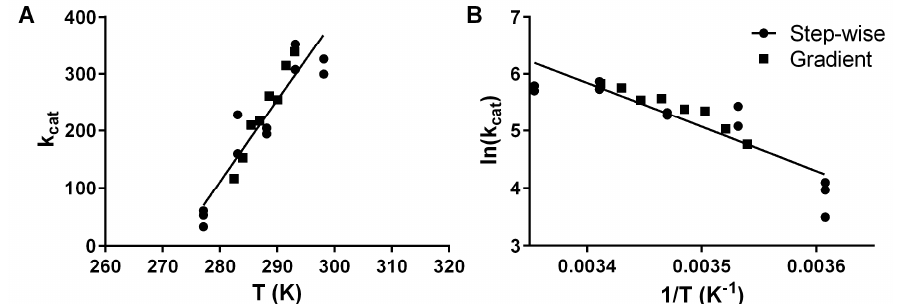
Figure 2. Arrhenius plot of activation energy for the hydrolysis of pNPB by pLipA with either the traditional stepwise approach, where separate experiments are performed for each temperature (circles), or by a gradient approach as we are proposing (squares) as k cat plotted against the absolute temperature ( A ) and ln( k cat ) plotted against the inverse temperature ( B ). For both plots, the globally fitted linear regression line is shown.